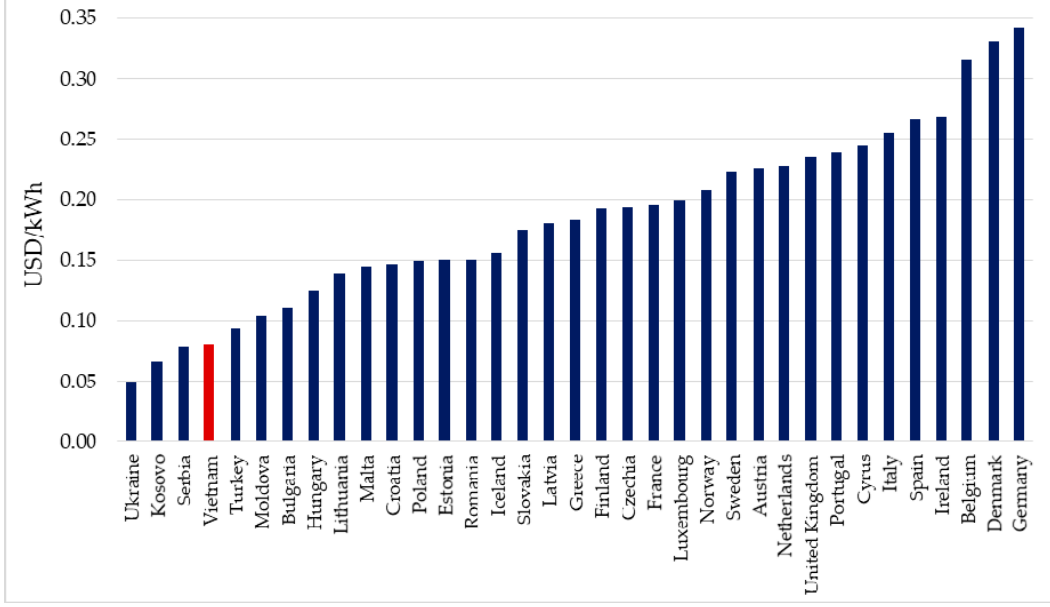
Figure 16. Retail electricity prices in some countries in 2019.